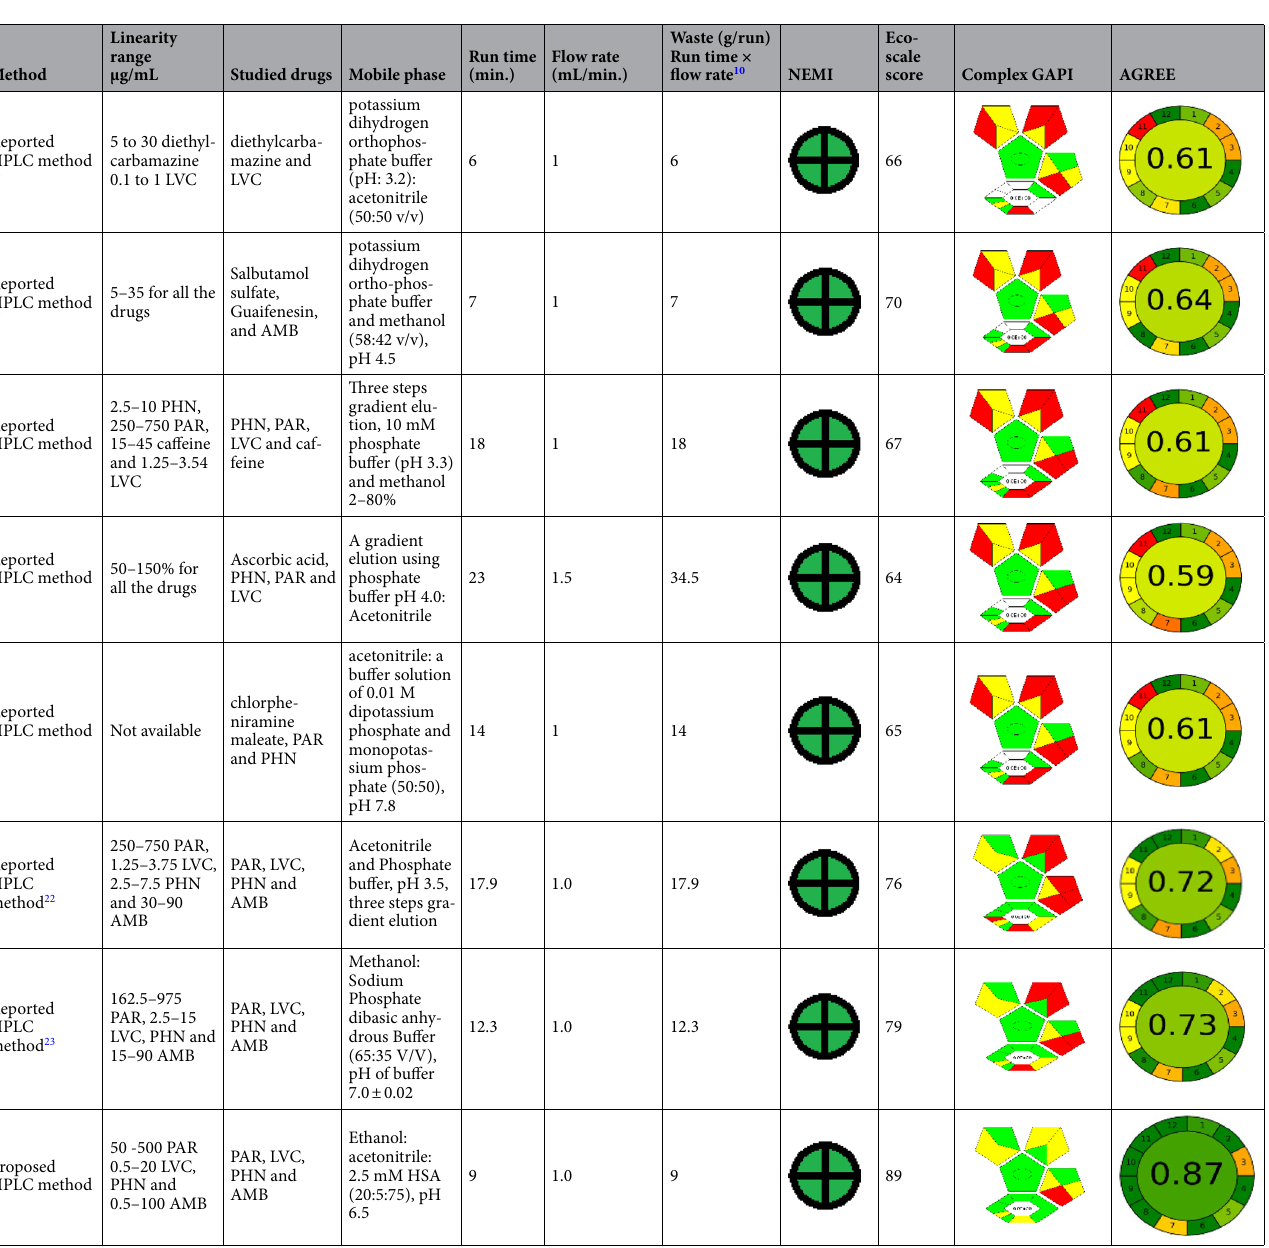
Table 9. Comparison of sensitivity and greenness report between the suggested and reported HPLC